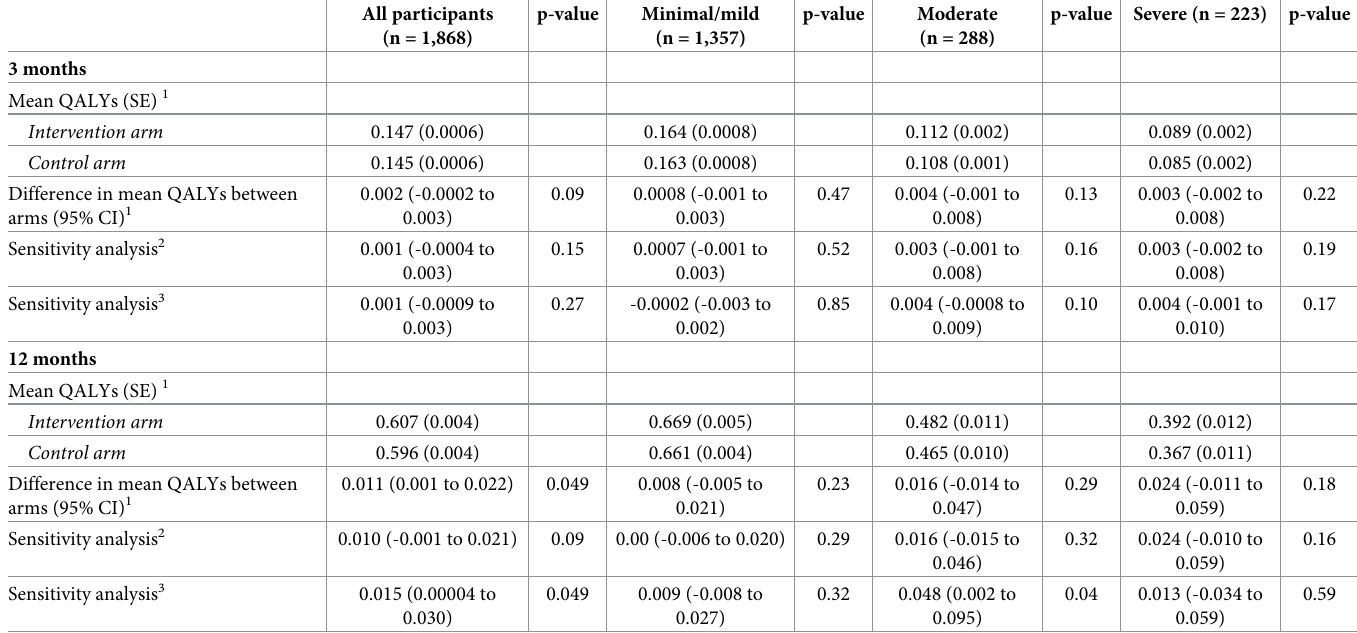
Table 3. Comparison of quality-adjusted life years by trial arm, across all participants and stratified by prognostic group (multiple imputed data).